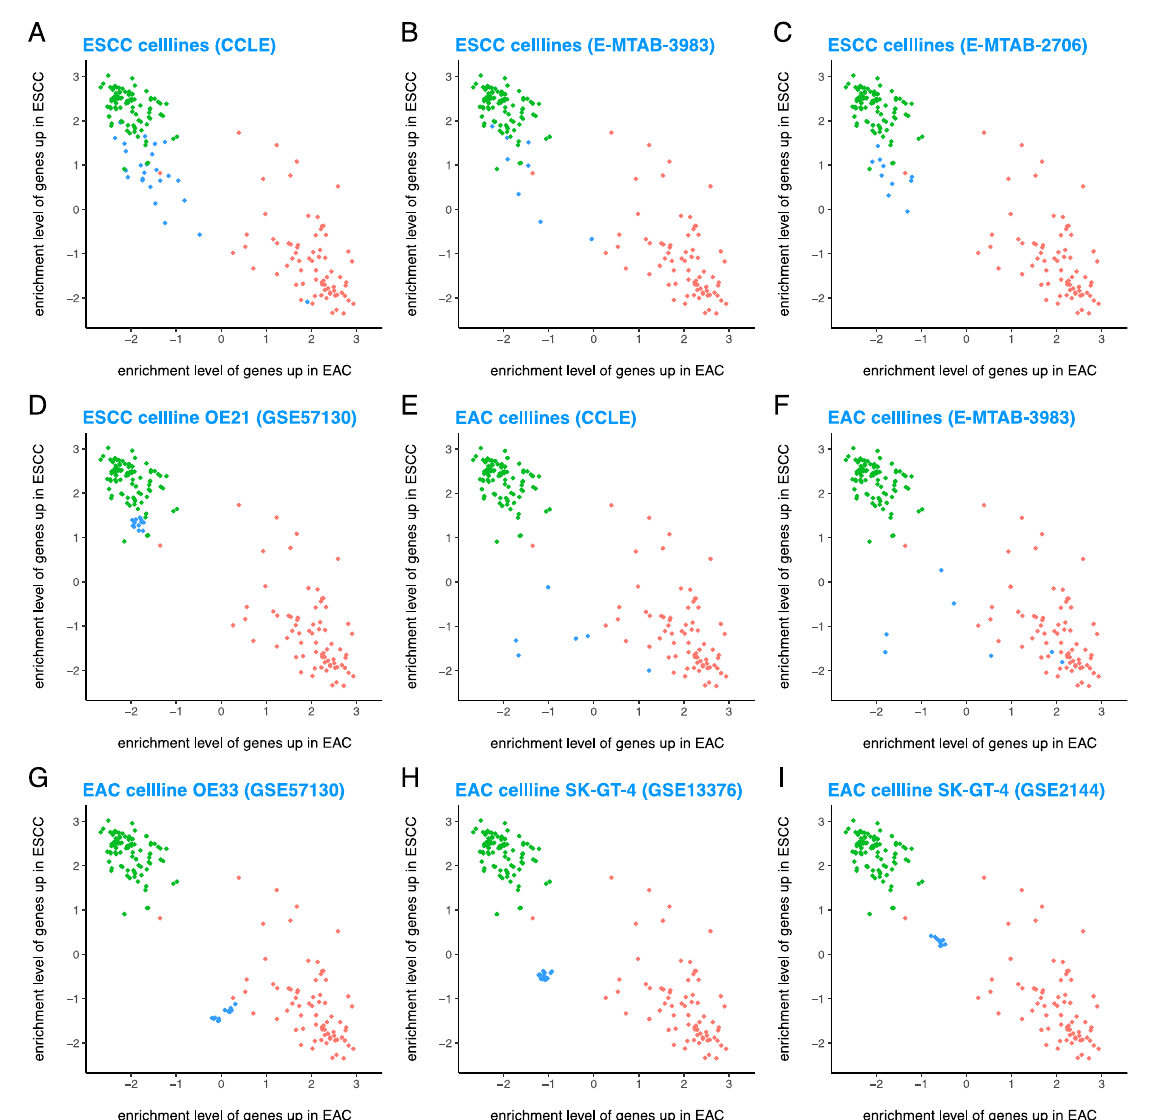
Figure 2. ESCC cell lines are quite similar to primary ESCC tumors, but EAC cell lines (although EAC-like) are considerably different from primary EAC tumors. Enrichment level of 100 EAC hi and 100 ESCC hi genes shows that ( A – D ) ESCC cell lines cluster with primary ESCC tumors, but ( E – I ) EAC cell lines often cluster near primary EAC tumors. Red = EAC cases from TCGA, green = ESCC cases from TCGA, and blue = test samples (various types of samples from datasets other than TCGA).